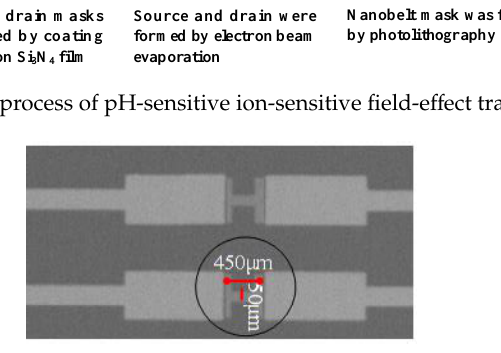
Figure 8. Electron microscopy of ISFET sensing area.